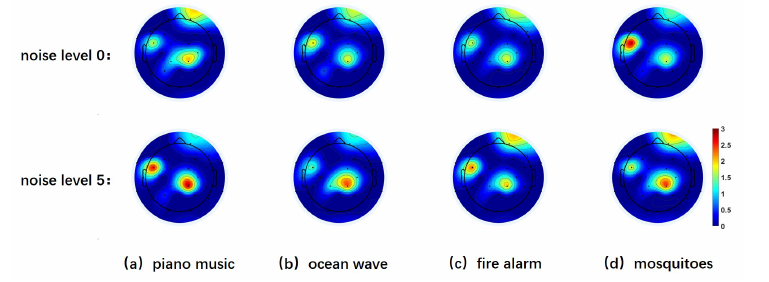
Figure 5. The brain topography of comprehensive weighted degree in four different audio scenarios under two extreme